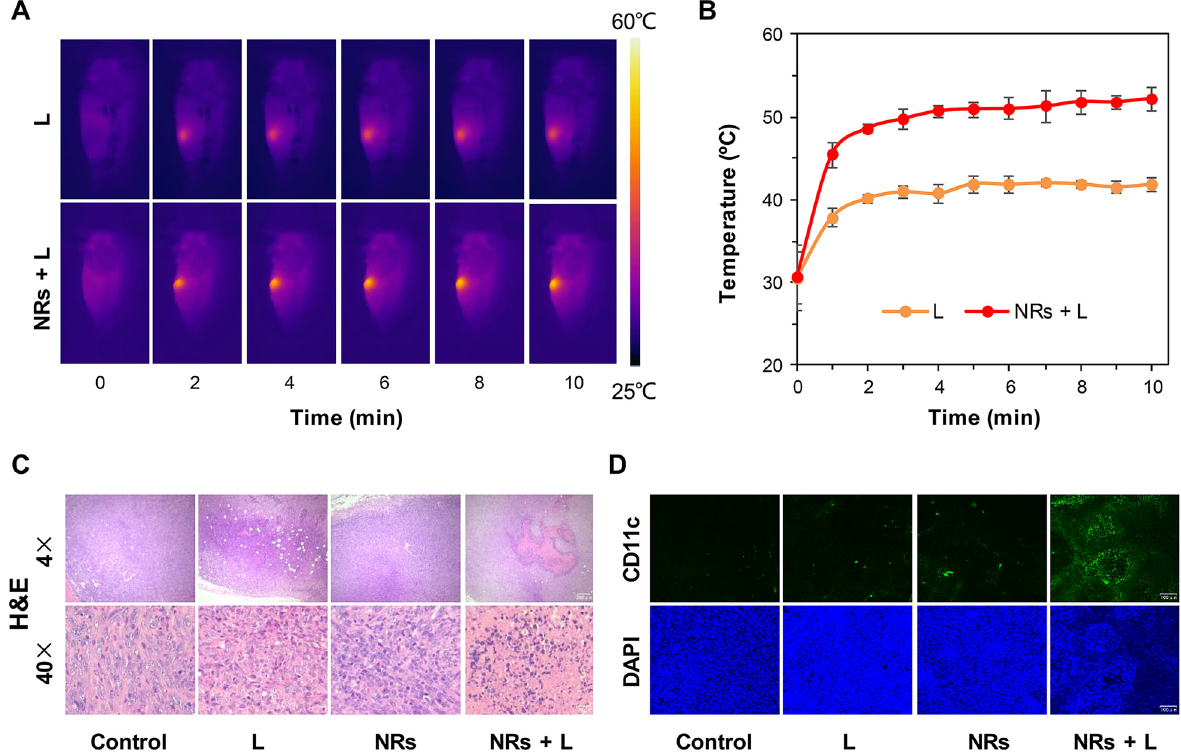
Figure 3: In vivo antitumor effect of Fe2P-PEG-Mal NRs based PTT on primary tumors. (A)InfraredthermalimagesofPanc02-H7tumor-bearingmiceunderlaserirradiation.(B)Temperatureelevationsontumorsurfaceduringlaser irradiation based on infrared thermal imaging data in (A) ( n = 3). (C) H&E staining images of excised tumors after different treatments (Upper: 4 × , scale bar: 200 μ m. Lower: 40 × , scale bar: 20 μ m). (D) Immuno fl uorescence images of excised tumors stained with anti-CD11c. Scale bar: 100 μ